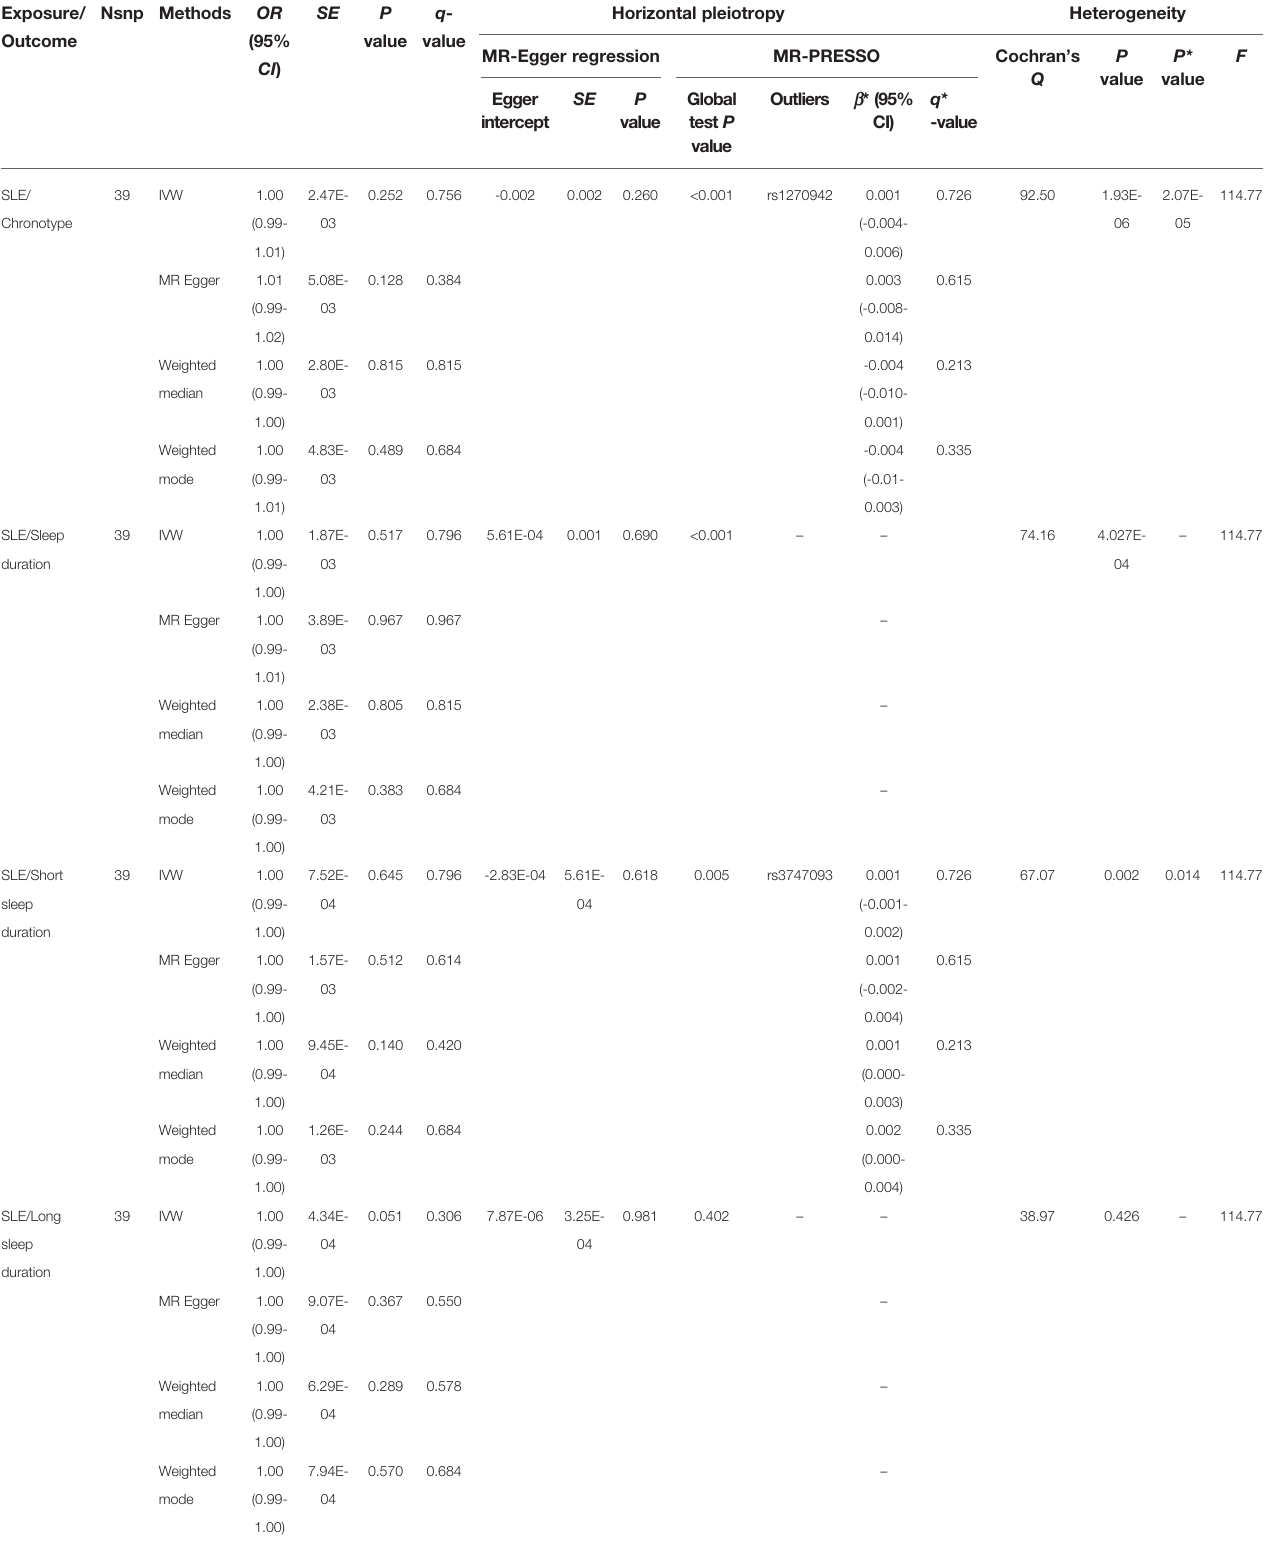
TABLE 2 | MR analysis of the causal relationship between SLE and the risk of sleep traits. Exposure/